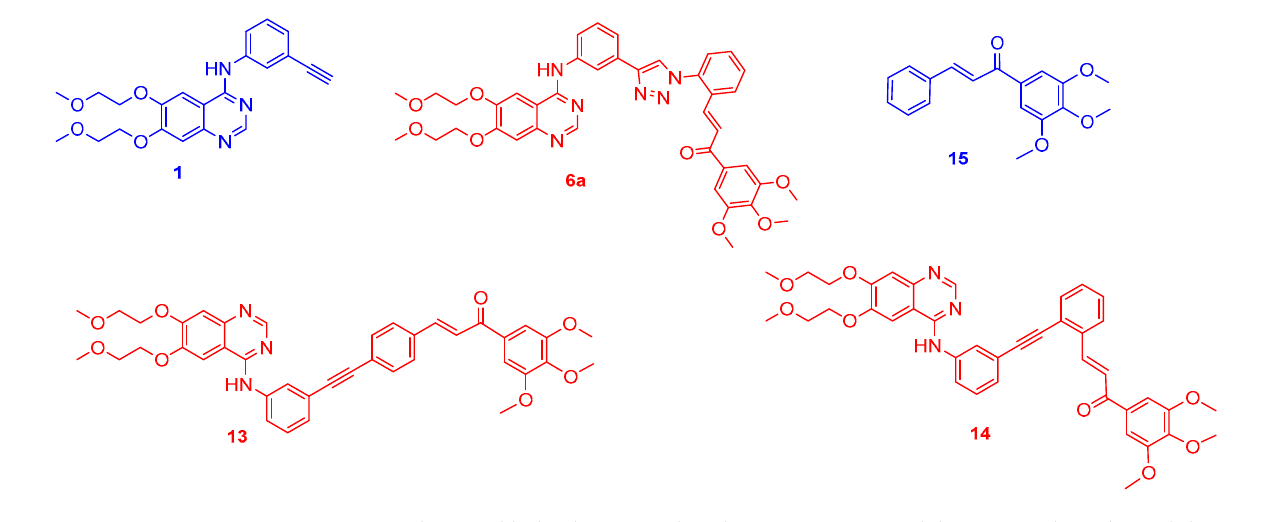
Figure 1. The novel hybrids emerged as the most potent model compounds in the viability assays ( 6a , 13 and 14 ), which were selected for further biological studies (red) using erlotinib ( 1 ) and chalcone ( 15 ) as reference fragments (blue) exploited in structure design.